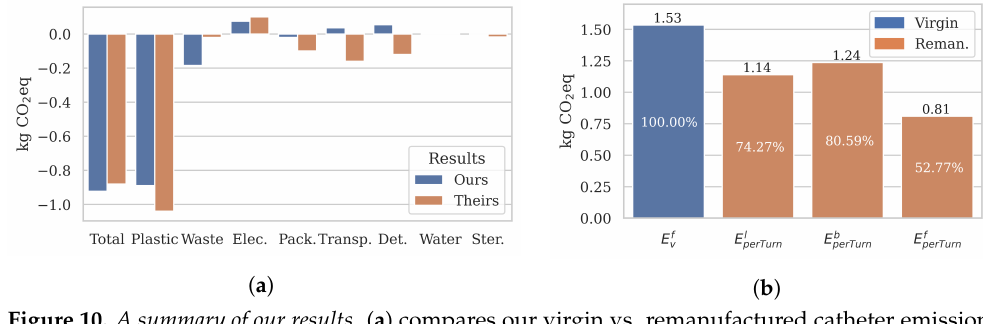
Figure 10. A summary of our results. ( a ) compares our virgin vs. remanufactured catheter emission results against the case study [10]. ( b ) illustrates how much the total remanufacturing emissions may vary depending on the selected emission metric. For a fair comparison, all remanufactured emissions are calculated for the same scenario ( N = 3, R = 50% and l = USA , as defined in Section